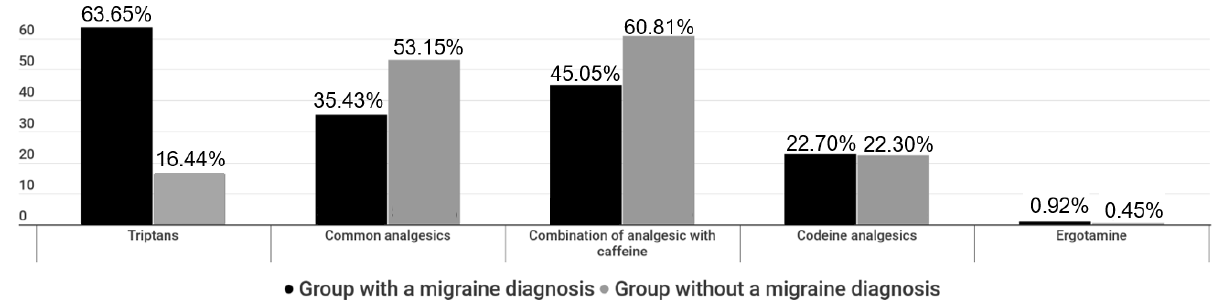
Figure 2. Acute symptomatic migraine treatments in both group A and B patients.